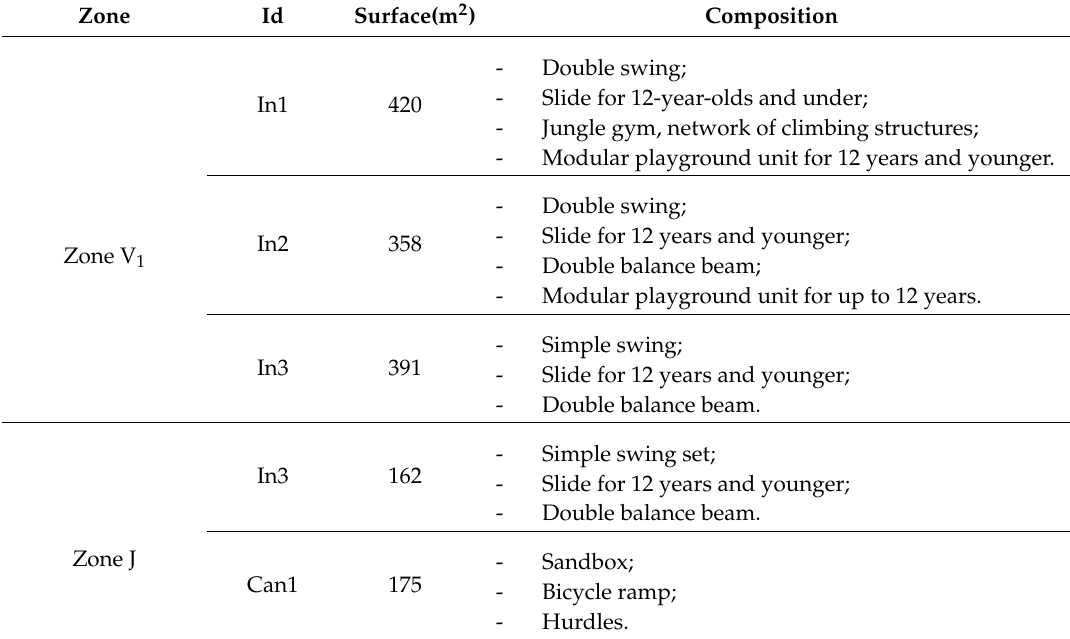
Table 3. Distribution of playground